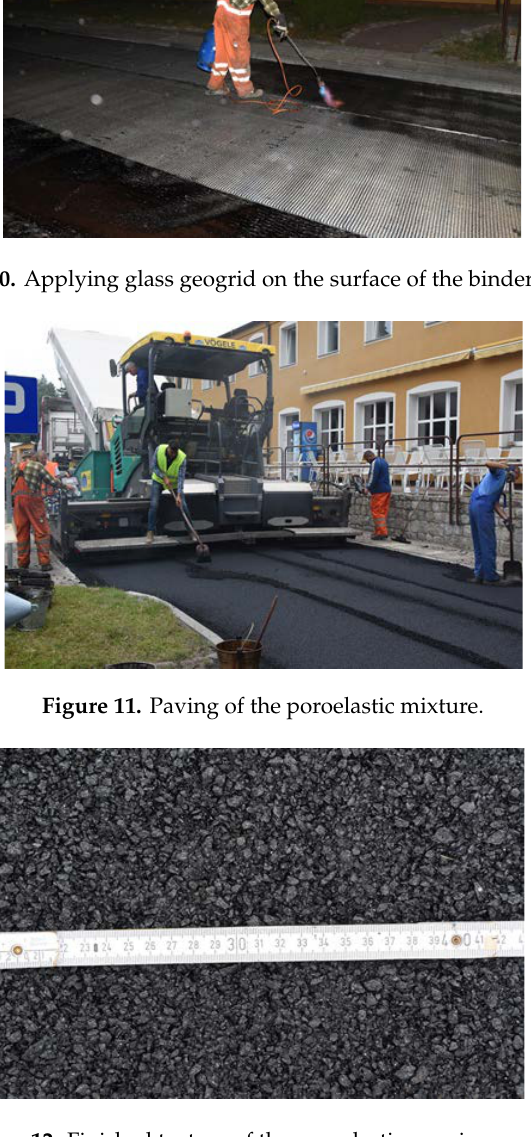
Figure 12. Finished texture of the poroelastic wearing course.